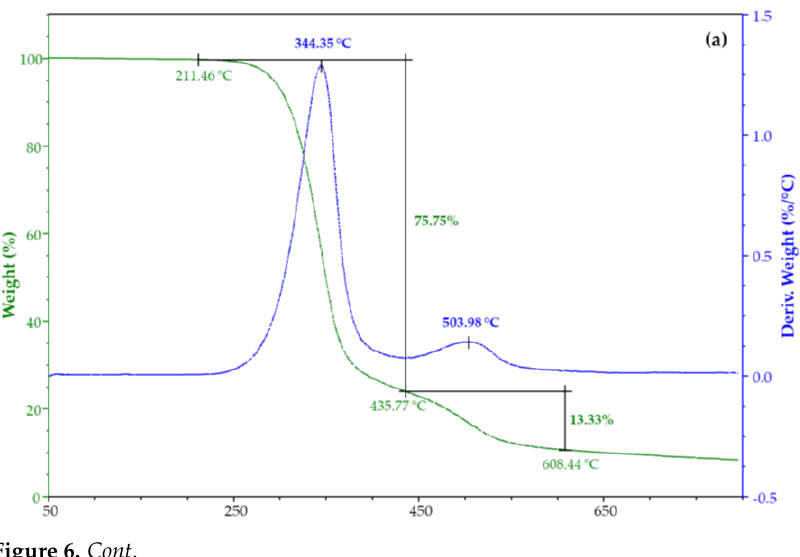
Figure 5. Reflectance (%) spectra of the ( a ) CX, ( b ) iodine, and ( c ) CX/iodine complex